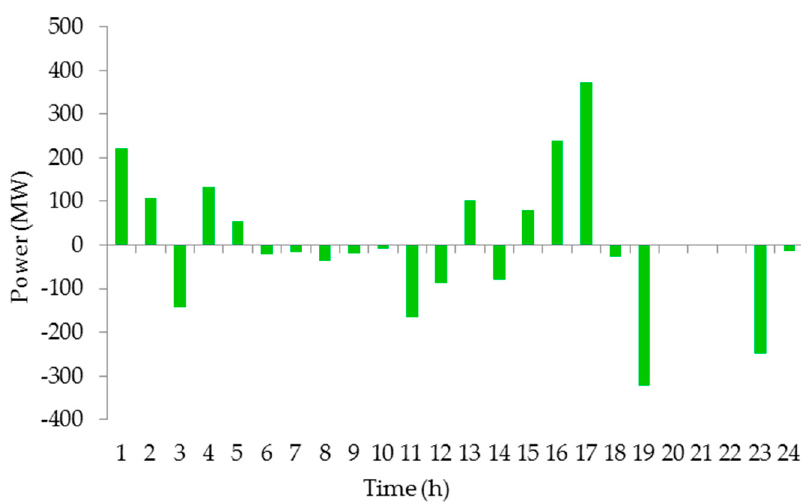
Figure 20. Power output curves of pumped storage in Case 4.